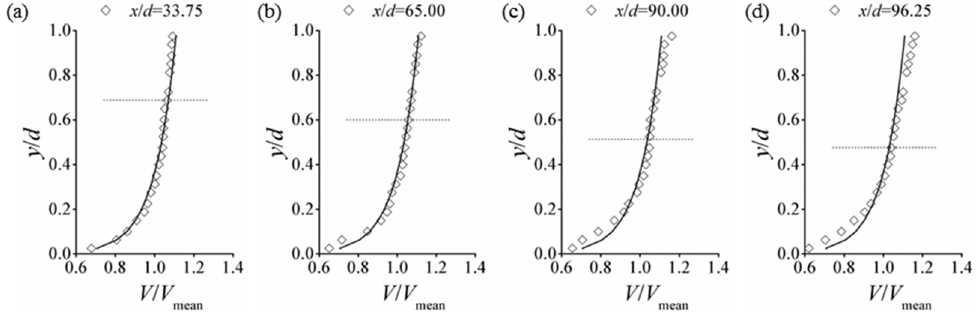
Figure 7. Mean time velocity profiles in the self-aerated developing region in chute flow for discharge rate Q = 0.21 m 3 /s: ♦ , experimental data; solid line, the log law, Equations (3)–(5); dot-dashed line, the maximum distance of air bubble diffusion to the channel bottom at each cross- section.